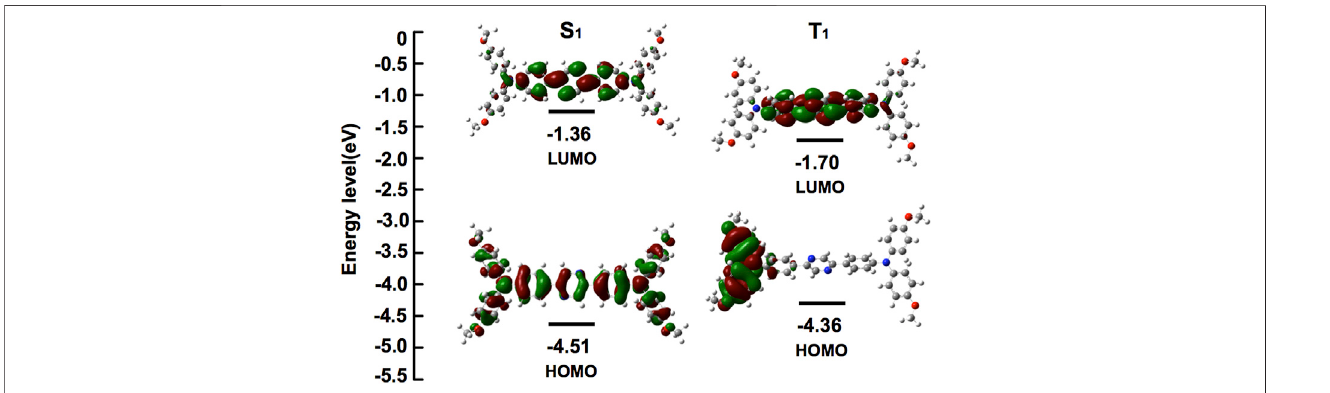
Frontiers in Chemistry |